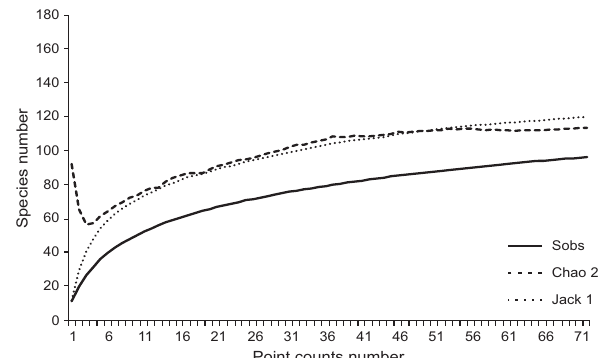
circles).Figure 3. Rarefaction curve (Sobs) and species richness estimates (Chao2 and Jack1) of the birds recorded with point